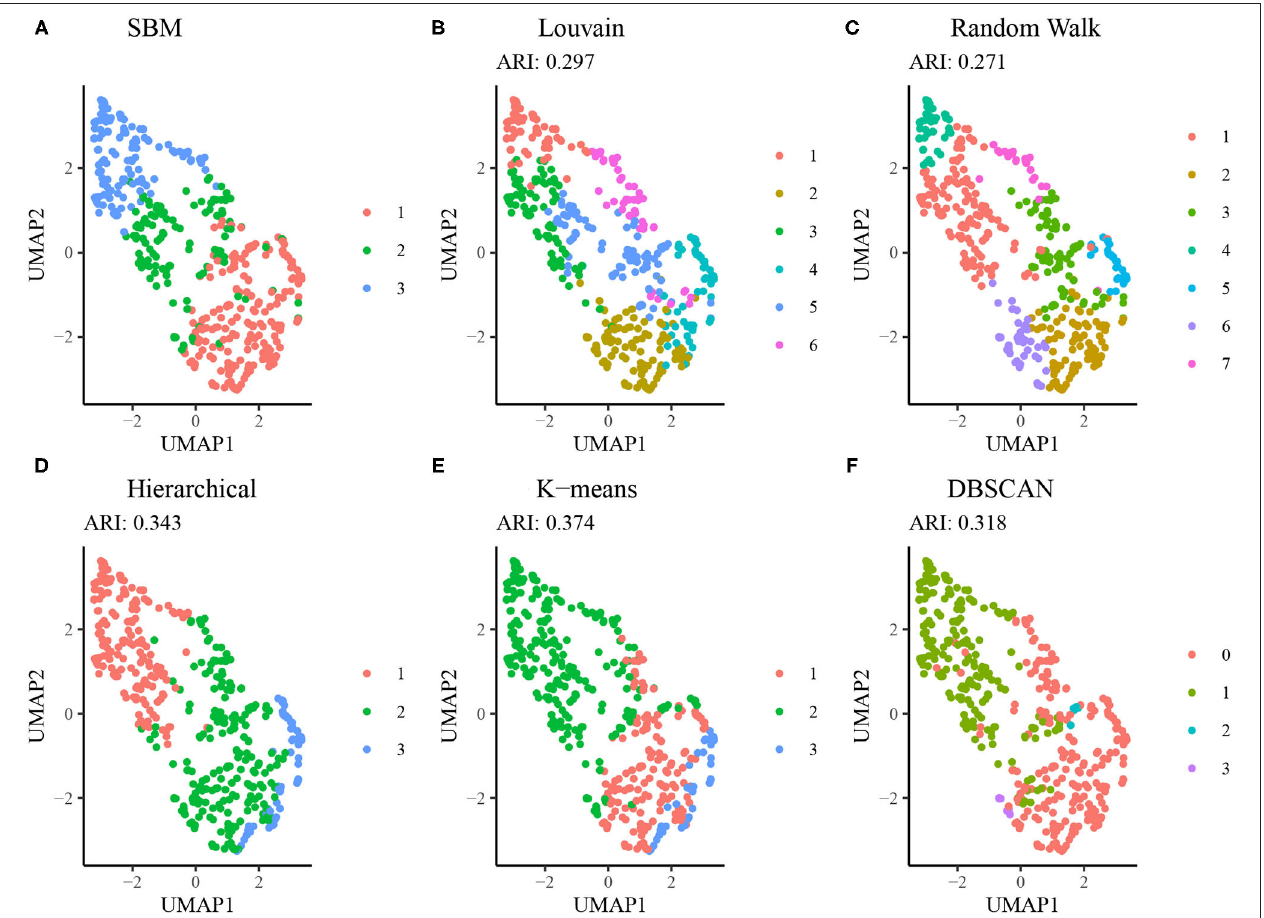
FIGURE 6 | Comparison of SBM performance relative to alternative methods. (A) Clustering results from the SBM using K algorithm (no tuning parameters available). (C) Clustering results from the Walktrap algorithm using random walks of length 4. (D) Hierarchical clustering results using a dendrogram cut at K 3. (E) K-means clustering results using the Hartigan-Wong method and K = minimum neighborhood size of 5.